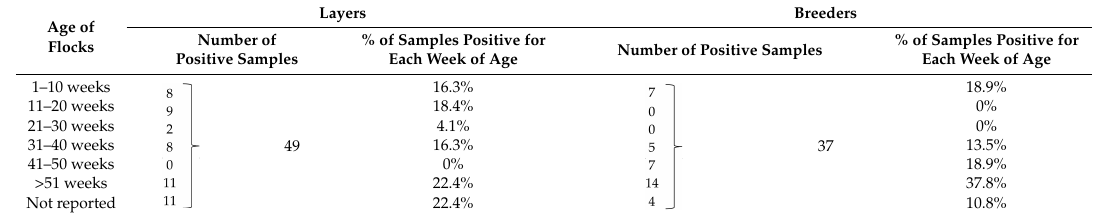
Table 4. Results of number of positive samples according to the age of layer and breeder flocks. Layers Breeders Age of % of Samples Positive for Flocks Each Week of Age Number of Positive Samples